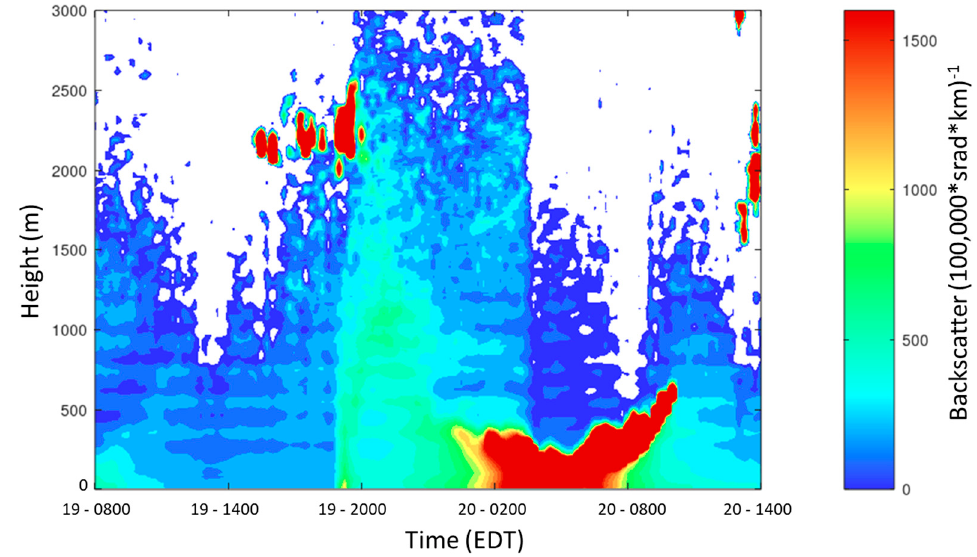
Figure 5. Backscatter from the SRS ceilometer for 2019 May 19 and 20. A sea breeze front passes at 1900 EDT on May 19.